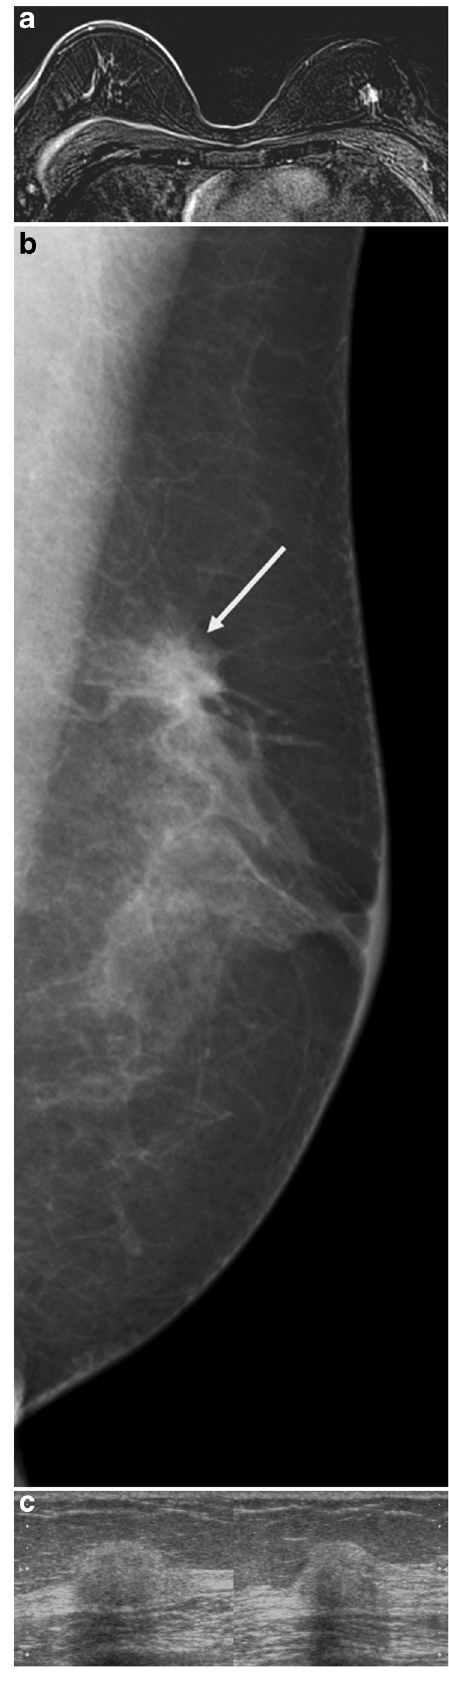
 Fig. 14 Invasive ductal carcinoma. Annual surveillance in a patient at very high risk already treated for left breast cancer. a MRI, gadolinium- enhanced T1 subtraction sequence, demonstrating an irregular, poorly circumscribed mass at the junction of the upper quadrants of the left breast. The gadolinium-enhanced examination shows initial 90% enhancement with washout at the late phase. b Mammography guided by MRI in the same patient, oblique view: demonstration of a non- calcified mass ( arrows ), with architectural distortion at the junction of the upper quadrants of the left breast. c MRI-guided ultrasound of the left breast in the same patient. At the junction of the upper quadrants, at the 12.30 position, 4 cm from the nipple, presence of a hyperechoic nodule with microlobular margins, with posterior attenuation classified as high ACR4. Microbiopsy demonstrated poorly differentiated invasive ductal carcinoma (grade II, low MI, HR+,